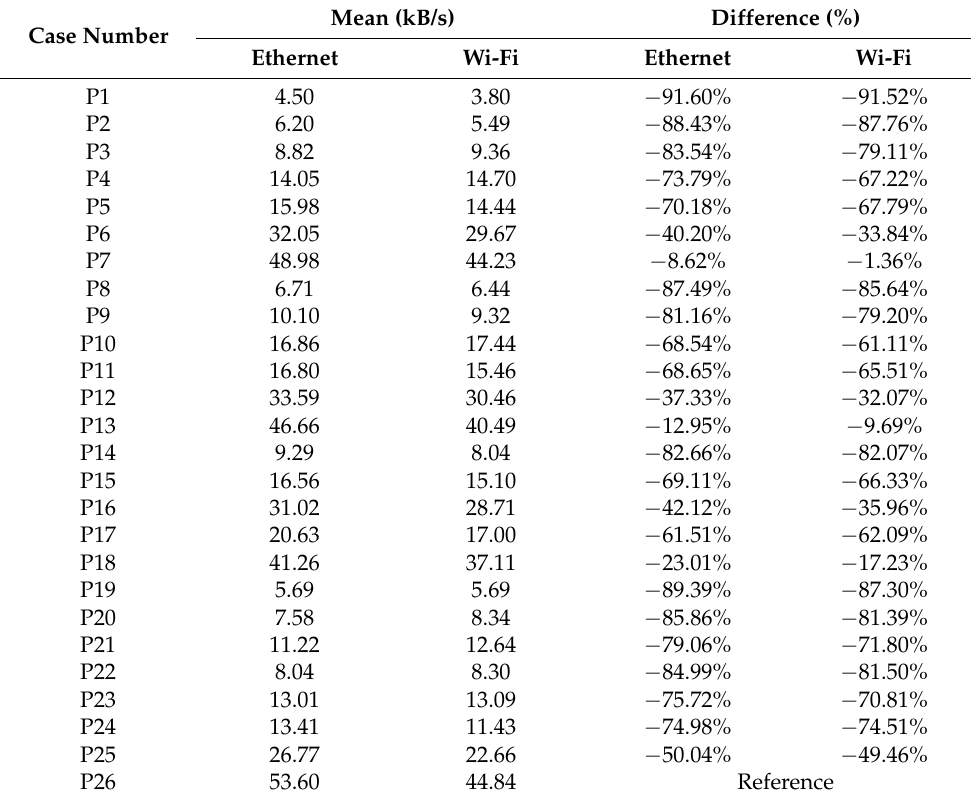
Table 5. Differences in data rate depending on the defined measurement